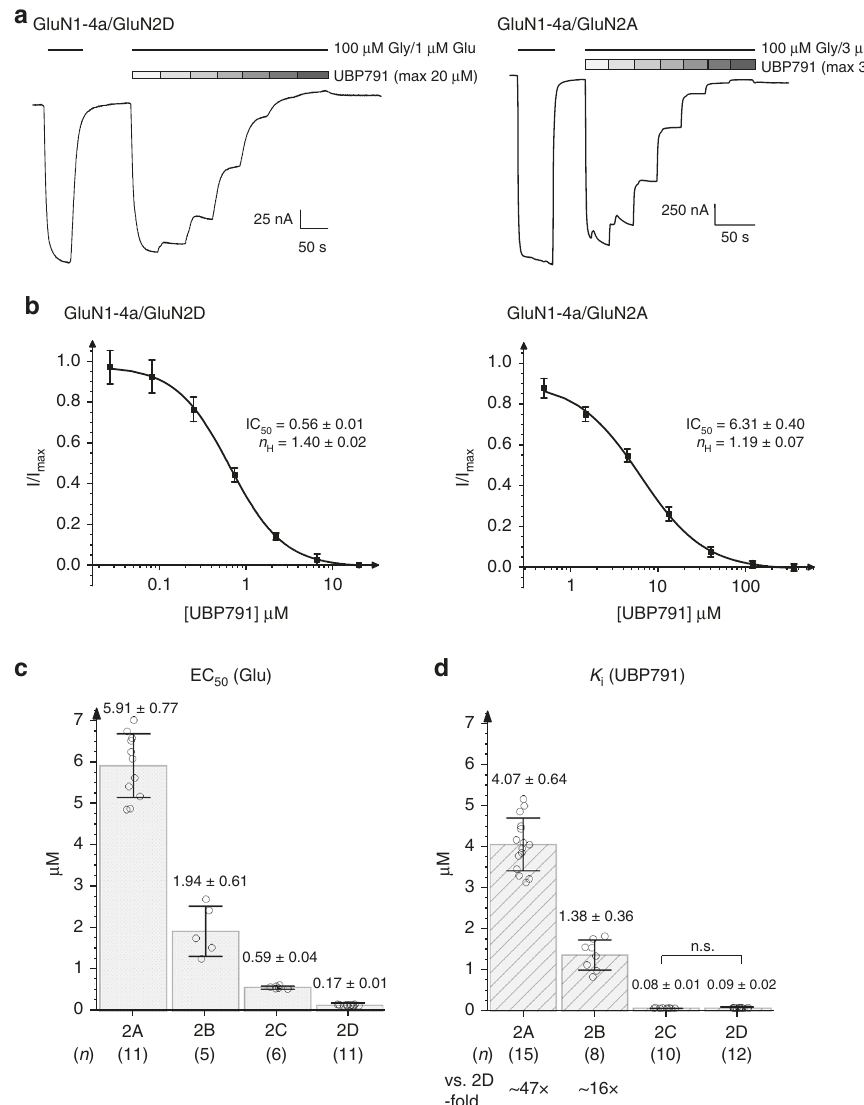
Fig. 2 UBP791 binds preferentially to GluN2C/2D-containing NMDARs over GluN2A/2B-containing NMDARs. a Representative TEVC dose-response traces of GluN1-4a/GluN2D (left panel) or GluN1-4a/GluN2A (right panel) NMDARs held at − 60 mV. Currents were evoked by application of 100 μ M glycine and 1 or 3 μ M L -glutamate and inhibited by varying concentrations of UBP791 (threefold increments to max. 20 and 360 μ M as shown). b Averaged dose-response curves (mean ± s.d.) for inhibition with UBP791 from ten GluN1-4a/GluN2D and 15 GluN1-4a/GluN2A recordings fi t with the Hill equation to calculate IC 50 and Hill coef fi cient ( n H ). c EC 50 values for GluN1-4a/GluN2 ( a – d ) obtained from L -glutamate dose-response curves. d Inhibition potency ( K i ) values calculated using the Cheng – Prusoff equation with the determined EC 50 and IC 50 values. Single data points are shown as open circles, the bar graph represents the mean with error bars for s.d., the number of recordings ( n ) and the fold difference to the K i of GluN2D are as shown. Pairwise comparison shows subtypes have different potencies ( p < 0.05 with two-tail t test and Bonferroni correction) except where stated